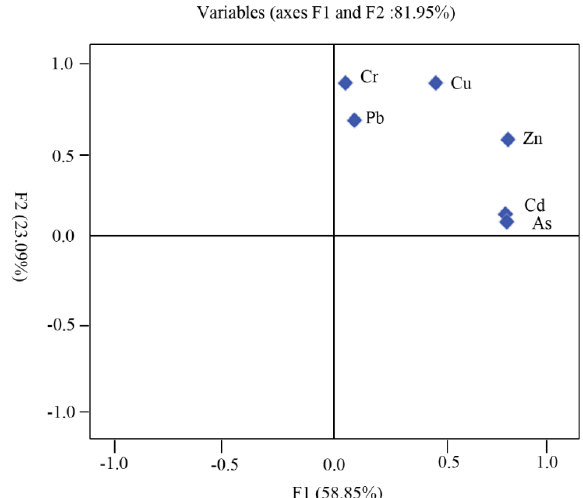
Figure 4. Plot of the loading of the first two rotated principle